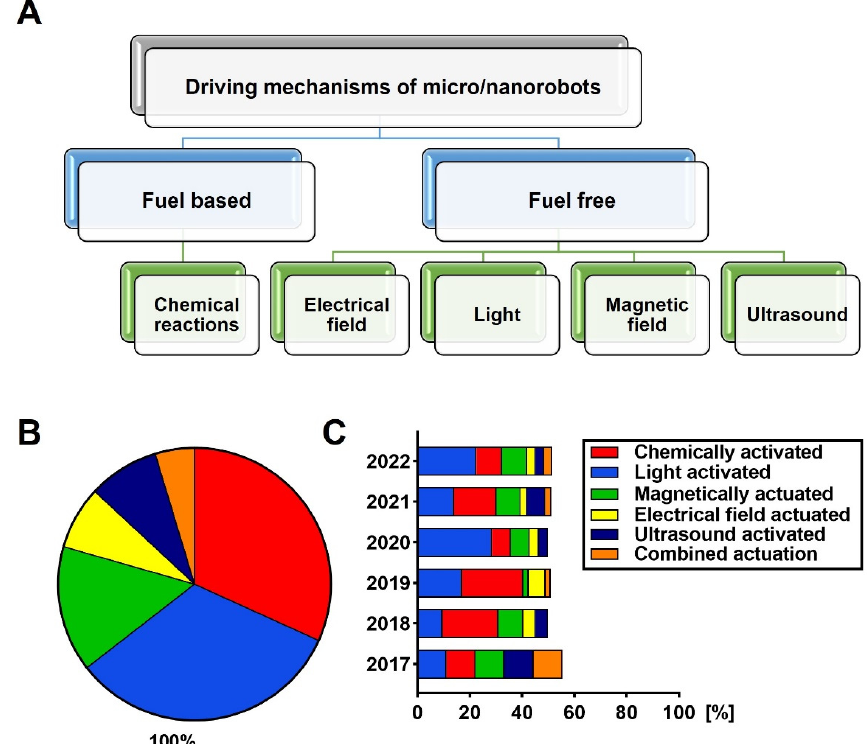
Figure 1. ( A ) Driving mechanisms of micro-/nanorobots. ( B , C ) Percentile distribution of micro-/nanorobot articles published in the last 5 years, regarding the driving mechanisms. Percentages are given as a part of the whole appearance graph in ( B ), and comparisons in each year are given as a bar graph in ( C ). The data are received from Web of Science and Scopus databases on 18 July 2022 with antimicrobial, ultrasound, electric field, magnetic field, and driving mechanisms keywords.